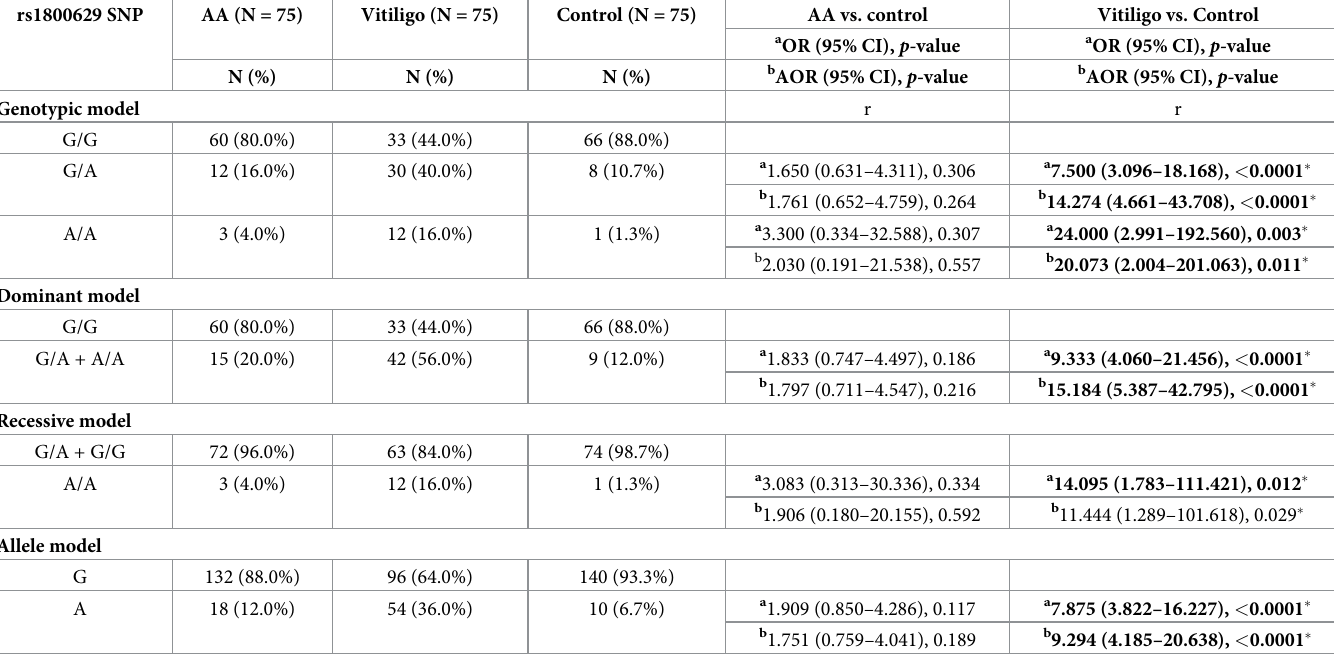
Table 4. Analysis of the association between TNF- α -308 G/A polymorphism and susceptibility to alopecia areata and